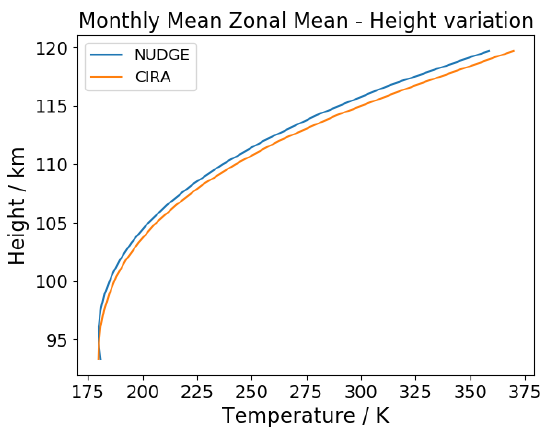
Figure 3. Variation in the zonal and monthly mean fitted nudging profile with height.